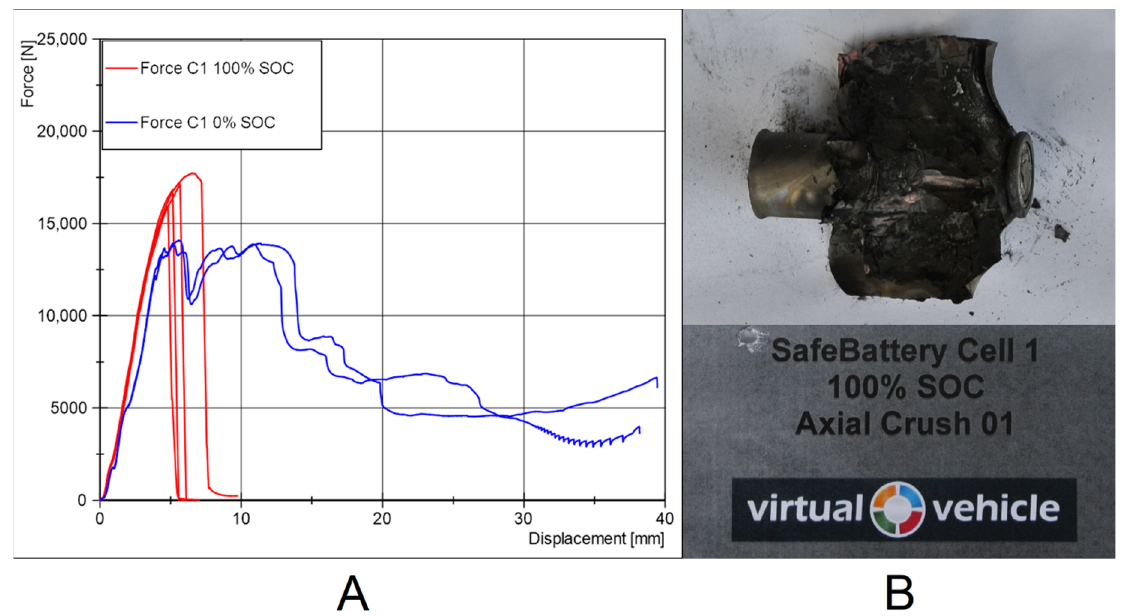
Figure A3. Axial crush C1 (SOC comparison) force over displacement ( A ) and cell specimen after testing ( B ). Figure A4 shows the test result for 0% SOC and for 0% SOC for the load-case radial crush. During the radial crush tests, forces exceeded the maximum of the measurement signal. A short circuit was still reached.